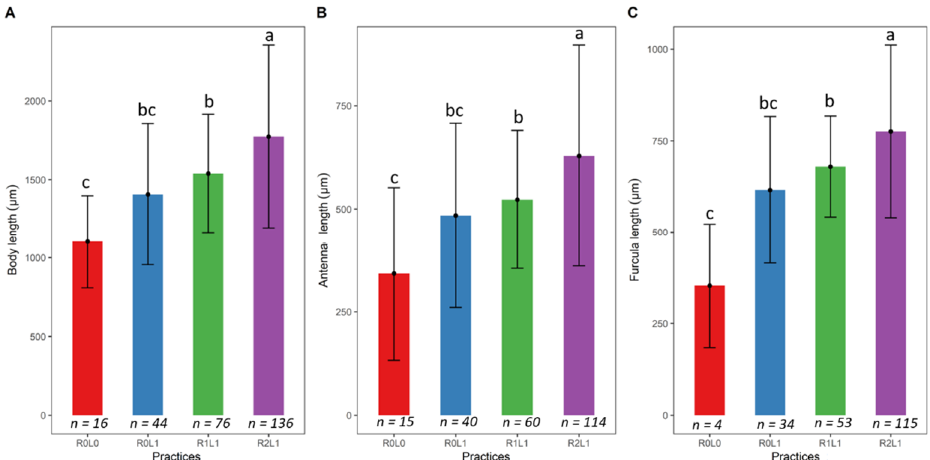
Figure 3. Average functional traits measured on the springtails according to the organic matter gradient. ( A ) Body length; ( B ) antenna length; ( C ) furca length. Different letters indicate significant differences according to the Tukey test. The vertical lines represent the standard error for each practice. R0L0 — no residue or legume in the plot, R0L1 — Legume ( Pueraria phaseoloides ) only, R1L1 — Legume + stump + leaf + fine branches, R2L1 – R1L1+ trunk.